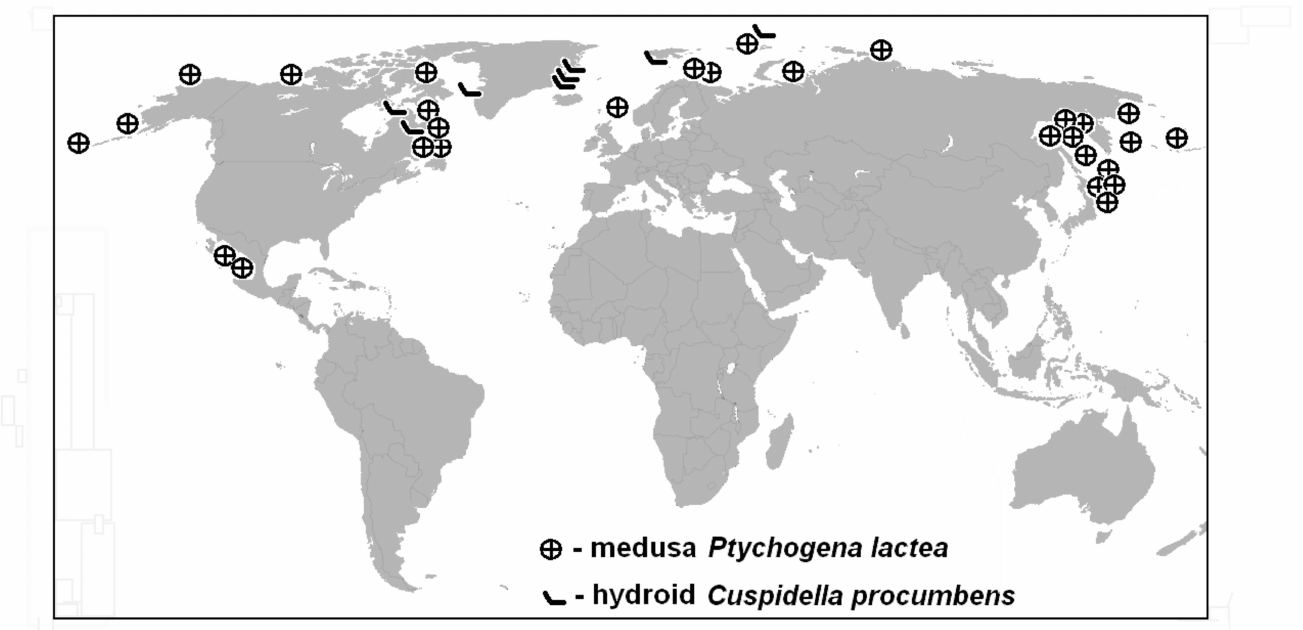
Figure 2. Co-distribution of hydroid Cuspidella procumbens Kramp, 1911 and medusa Ptychogena lactea A. Agassiz, 1865. Each symbol means from one to several (or many) finds, located nearby. Several records and some good photographs by Claude Nozeres from NE Canada: Baffin Island (Frobisher Bay), Labrador Sea (Smith Sound, Jones Sound), Nova Scotia, Halifax, Quebec—Rimouski, Fleuve Saint-Laurent